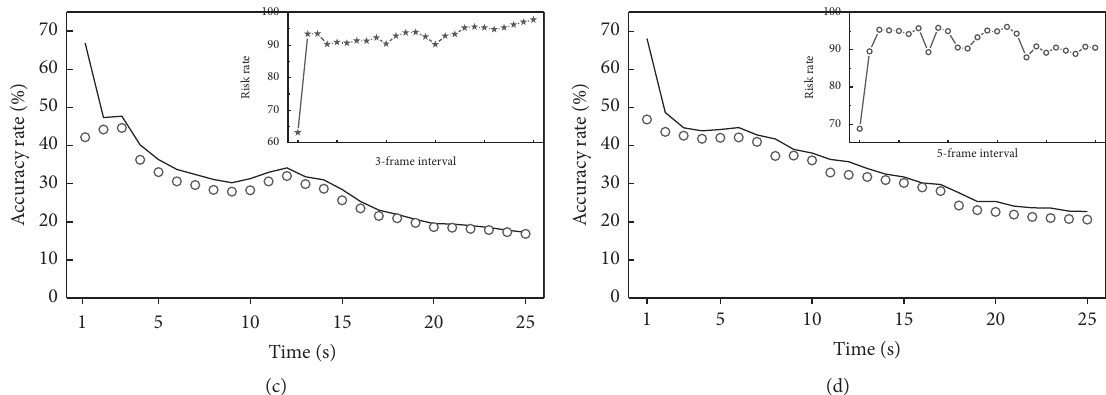
Figure 4: Accuracy of action recognition with different sampling methods.